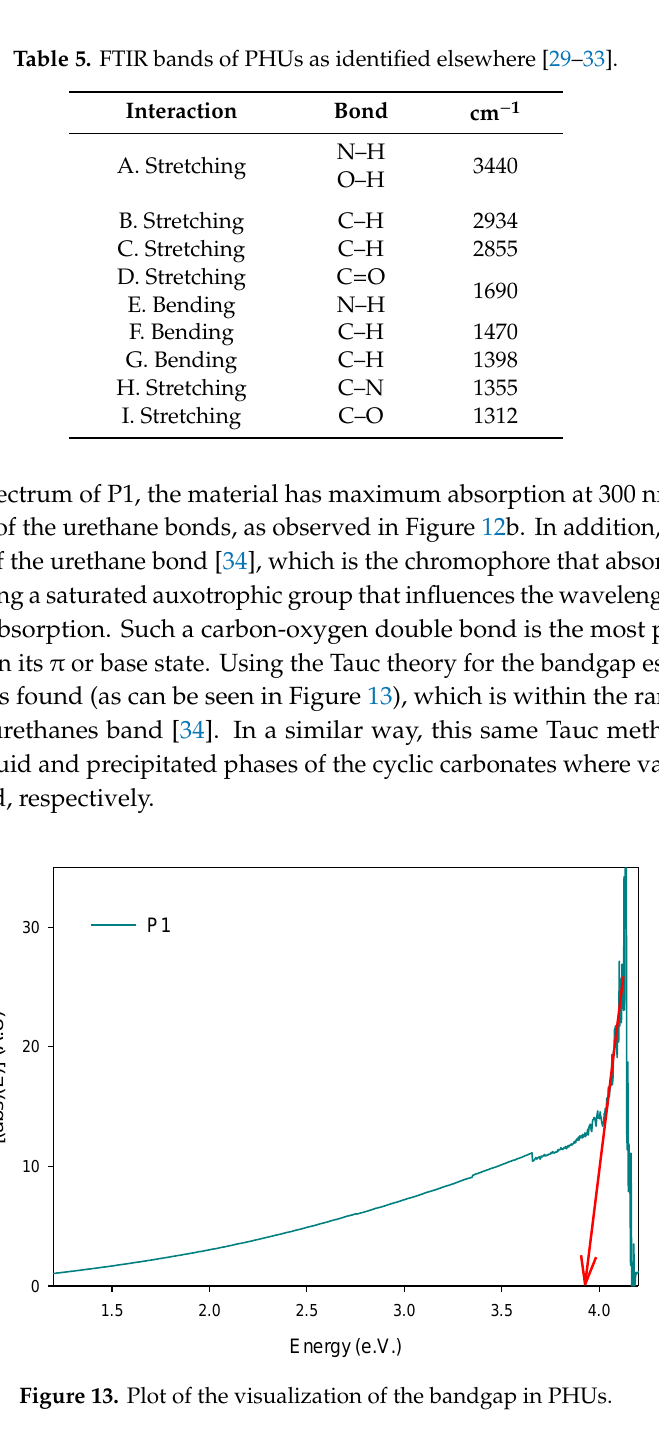
Table 5. FTIR bands of PHUs as identified elsewhere [29–33].